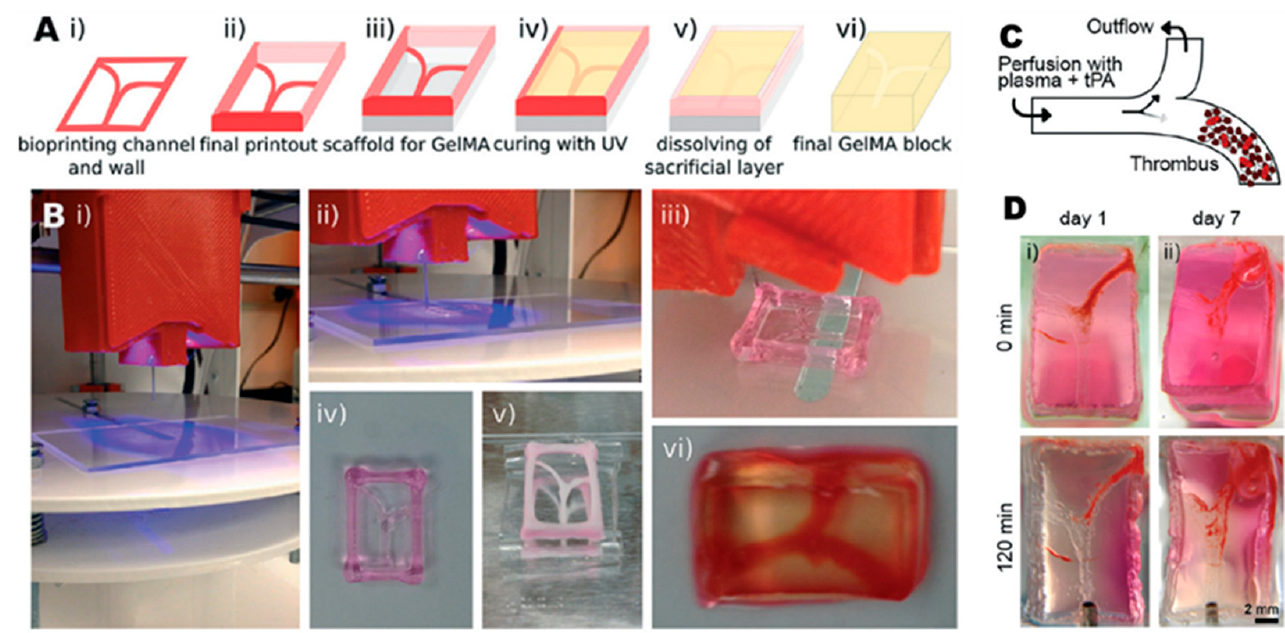
Figure 2. Three-dimensional bioprinted vasculature network to model thrombosis on a chip. ( A ) Three-dimensional bioprinting process patterning schematic. ( B ) Illustration of the experimental procedure step by step according to A. ( C ) Representation of the microfluidic setup. ( D ) Time-lapse photographs of the thrombosis clot at day 1 (i) and day 7 (ii). Reprinted and edited with permission granted by Copyright Clearance Center, Inc. (“CCC”). Published in Lab on a Chip journal, by the Royal Society of Chemistry, Vol 16, by Y.S. Zhang et al., “Bioprinted thrombosis-on-a-chip” [65].